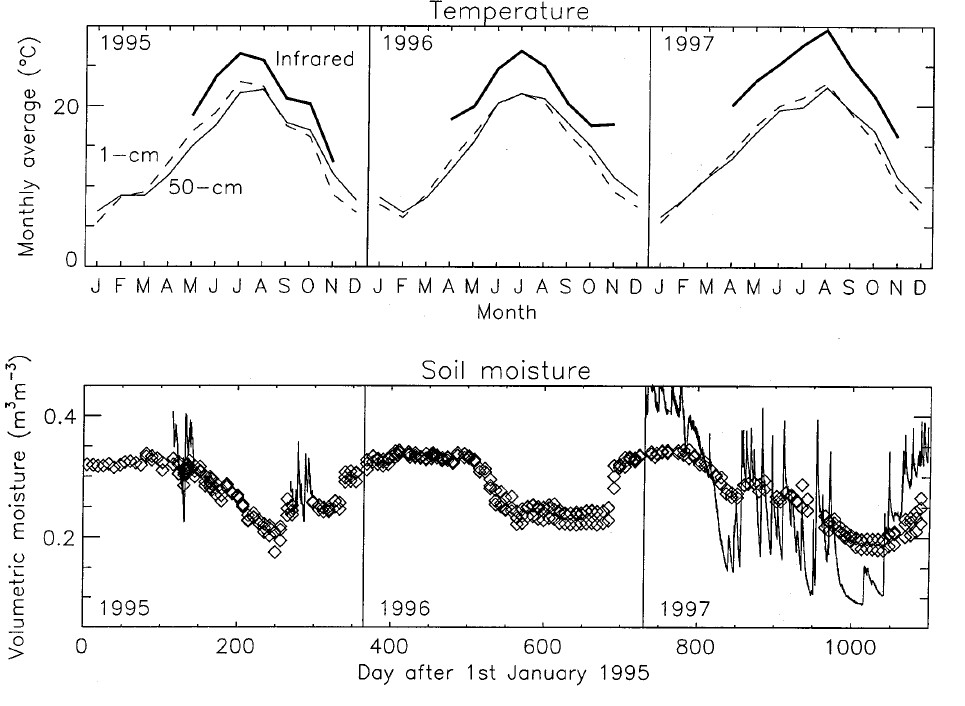
Fig. 8. Monthly averages of the measured infrared-derived sur- face temperature ( thick solid line ), and of the soil temperature at 1-cm ( dashed line ) and 50-cm ( solid line ) below the soil surface, and the measured soil water content of the 1.35 m column ( diamonds ) and surface soil wa- ter content over the top 5–6 cm ( solid line ), in 1995, 1996,